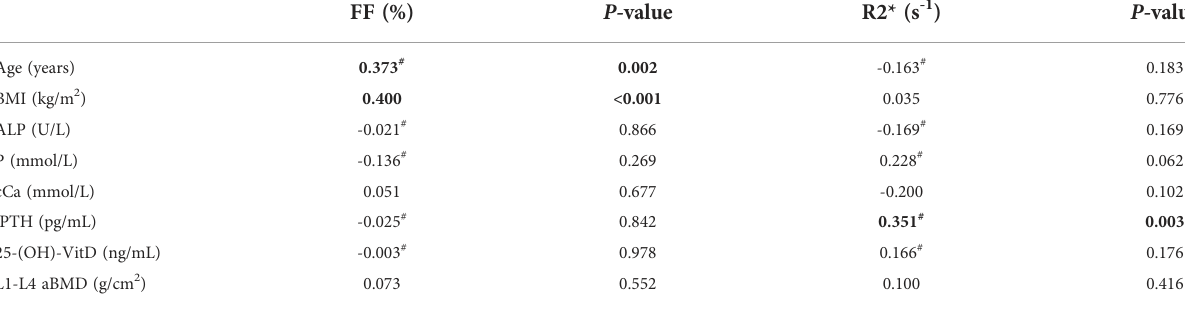
TABLE 2 Correlation analysis of MRI measurements (FF and R2*) with demographics and clinical characteristics.